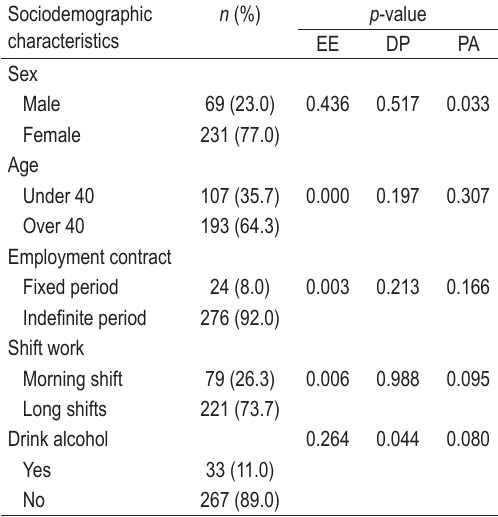
TABLE 2. Sociodemographic characteristics of the study population Sociodemographic